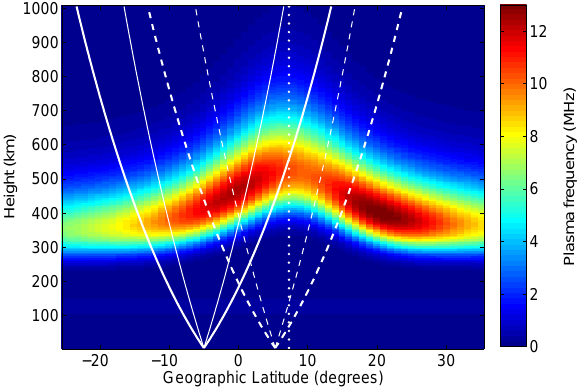
Geographic Latitude (degrees) Fig. 11. IRI90 derived plasma frequency as a function of geo- graphic latitude and height. The solid lines represent north and south bound rays with elevations of 15 ◦ (thick) and 30 ◦ (thin) orig- inating from Pare Pare while the dashed lines are similar rays orig- inating from Marak Parak. The ray paths appear curved due to the representation of curved Earth geometry in a rectilinear coordinate system. The dotted line indicates the geomagnetic